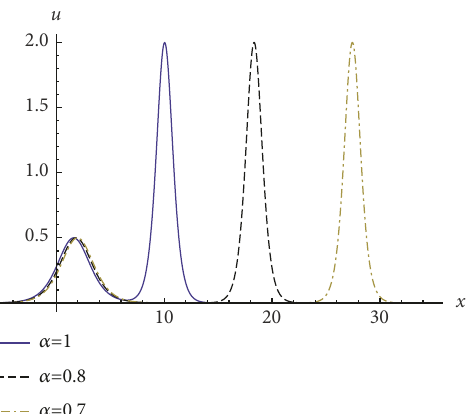
Figure 7: Fractional three-solitons determined by solution (45) at 𝑡 = 1 . presented in this paper for constructing n -soliton solution of the local tfKdV eq. (1) can be extended to some other integrable local time-fractional